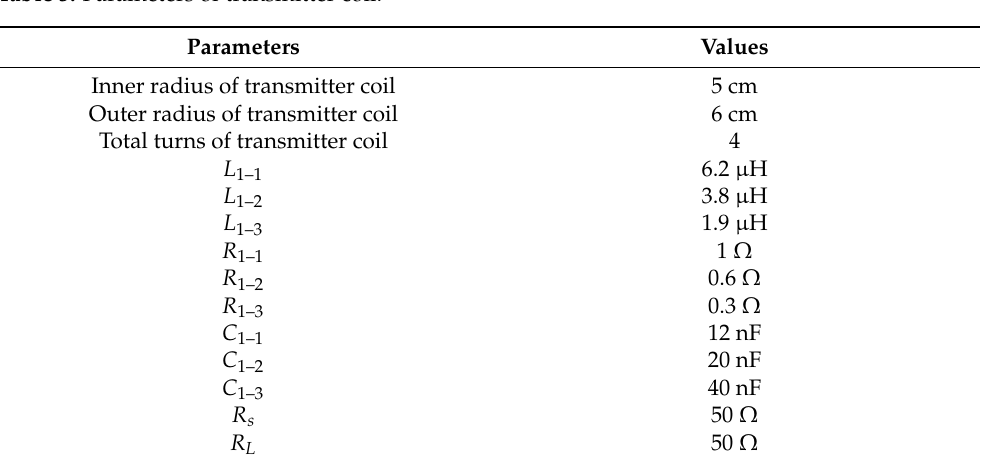
Table 3. Parameters of transmitter coil.